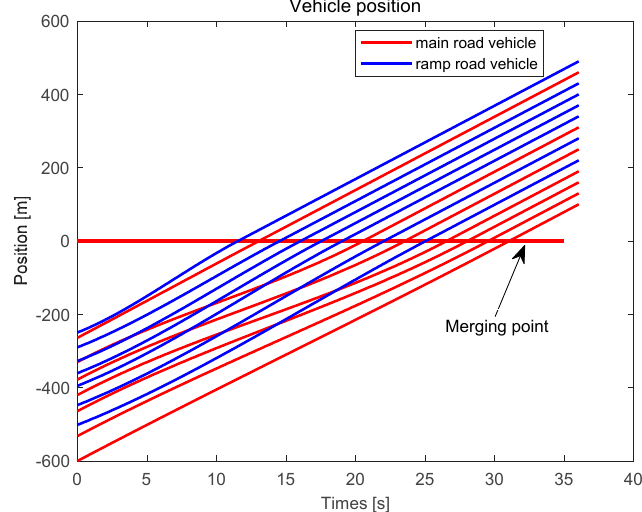
Figure 5. Position trajectory of vehicles for case study 1.